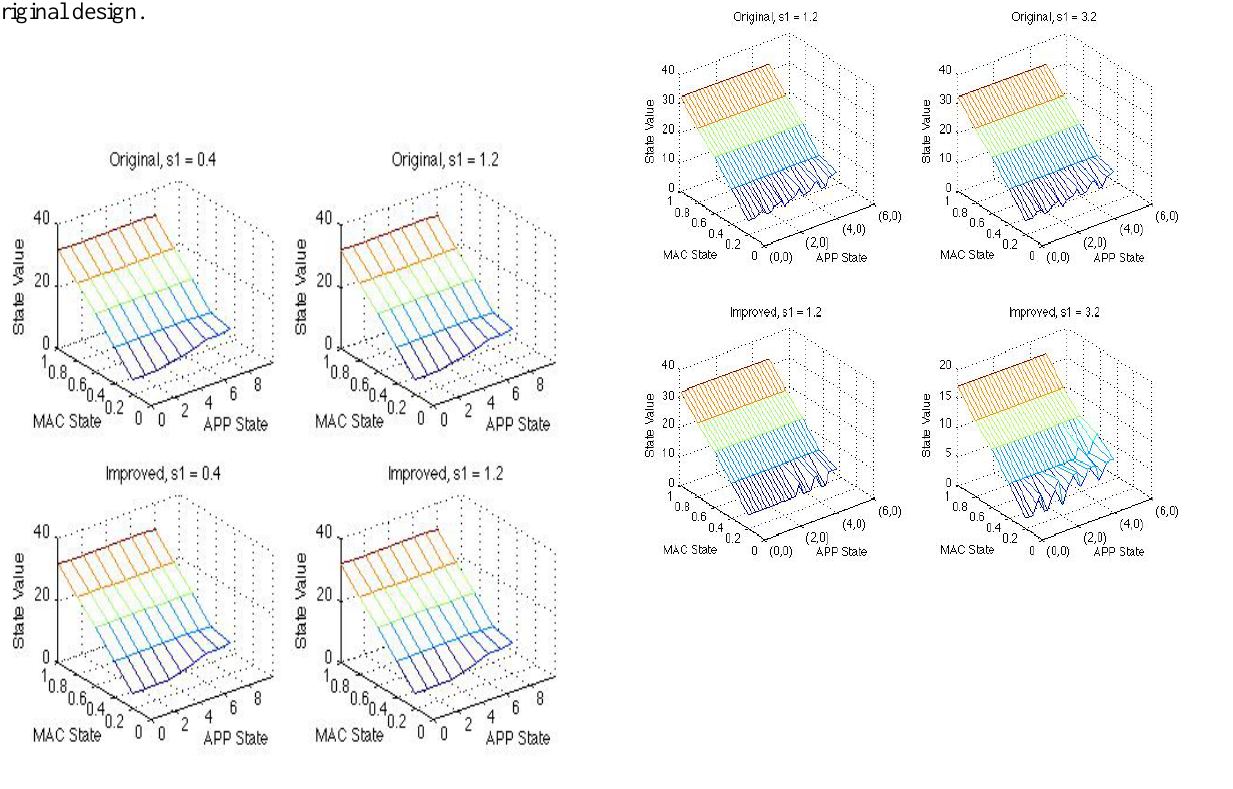
Figure 5b. Simulated state value of delay sensitive application for cellular network.